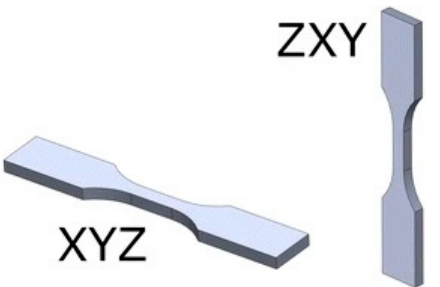
Figure 13. Printing directions. Reprinted from [43], © 2014, with permission from Springer Nature.